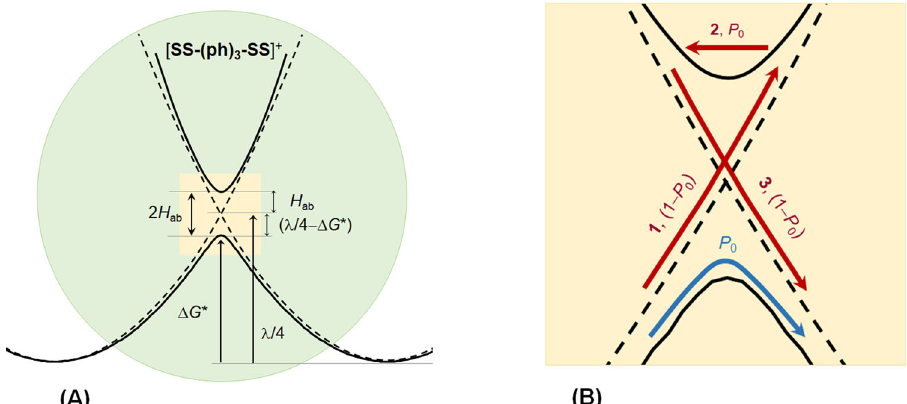
Fig. 5 Schematic representations of the energetic features of the crossing region and nonadiabatic transition channels for the transient systems. A The diabatic (dashed line) and adiabatic (solid line) potential energy surfaces in the reactant and product equilibriums and the transition state (shaded area) for [ SS – (ph) 3 – SS ] + . B The fi rst (cyan) and second (red) channels of nonadiabatic transition in intermediate system [ SS – (ph) 3 – SS ] + . The potential surfaces in A and B result from zooming in of the avoided crossing area in Fig. 4B. Similar results are expected for [ OS – (ph) 3 – OS ] + from the similar λ and